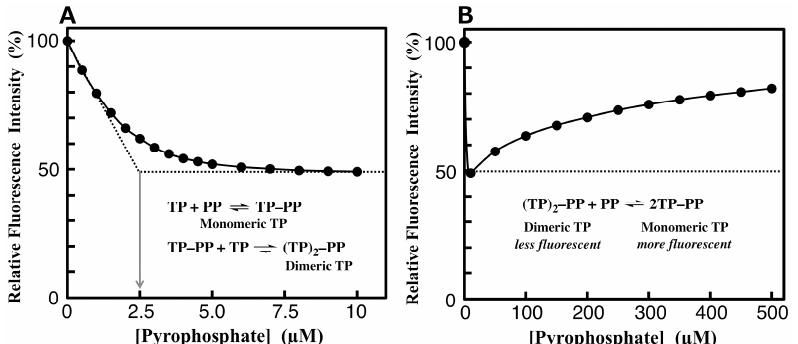
Figure 5. Structure of the dimeric TAMRA-Phos-tag complex linked with pyrophosphate, and the hydrolysis of pyrophosphate to reduce the fluorescence quenching effect at pH 7.4 in aqueous solution.